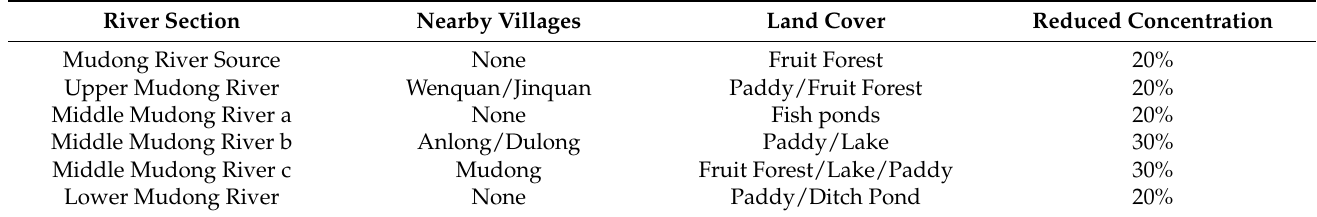
Figure 7. Scenario 3 model of 123 d and 245 d total nitrogen simulation results. The reduction of fertilizer application by 25% in sub-basins S1, S3, and S4 in Scenario 1 reduced the TN load by 11.8%, 31.5%, and 22.5%, respectively. This indicates that the reduction of fertilizer application in rice fields had a greater effect on reducing the surface source pollution load. From the migration of early rice tillers after fertilization on day 123 in Figure 4, it can be seen that the shallow groundwater TN concentration in the southern paddy field area of the S3 sub-basin decreased by 2 mg/L on average due to the reduction of early rice fertilization, which in turn improved the water quality of Mudong Lake. From the simulation results of late rice transplanting after basal fertilization on day 245 in Figure 4, the total nitrogen concentration of shallow groundwater in the Fishang area in subbasin S1 (Figure 2) and Mudong Lake in subbasin S3 decreased slightly. In sub-basin S4, the width of the pollution plume in Steepmen village became narrower by about 0.8 km, re- ducing the risk of further groundwater quality contamination in Dayuantou village.